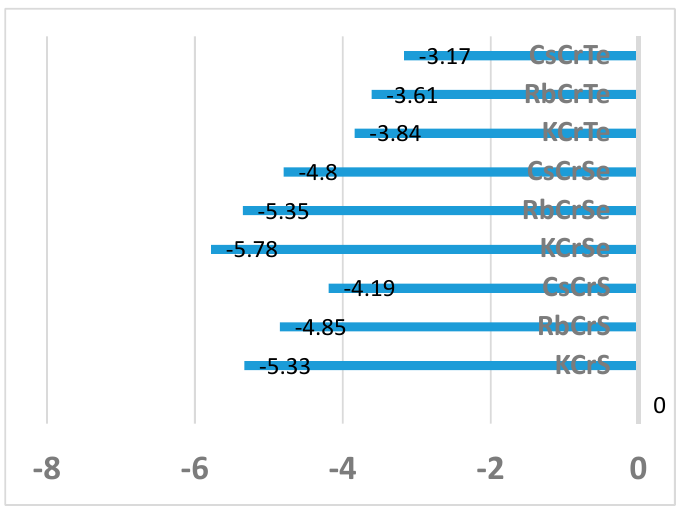
Figure 9. Calculated formation energies (eV) for the XCrZ (X = K, Rb, Cs; Z = S, Se, Te) alloys with the most stable phase.